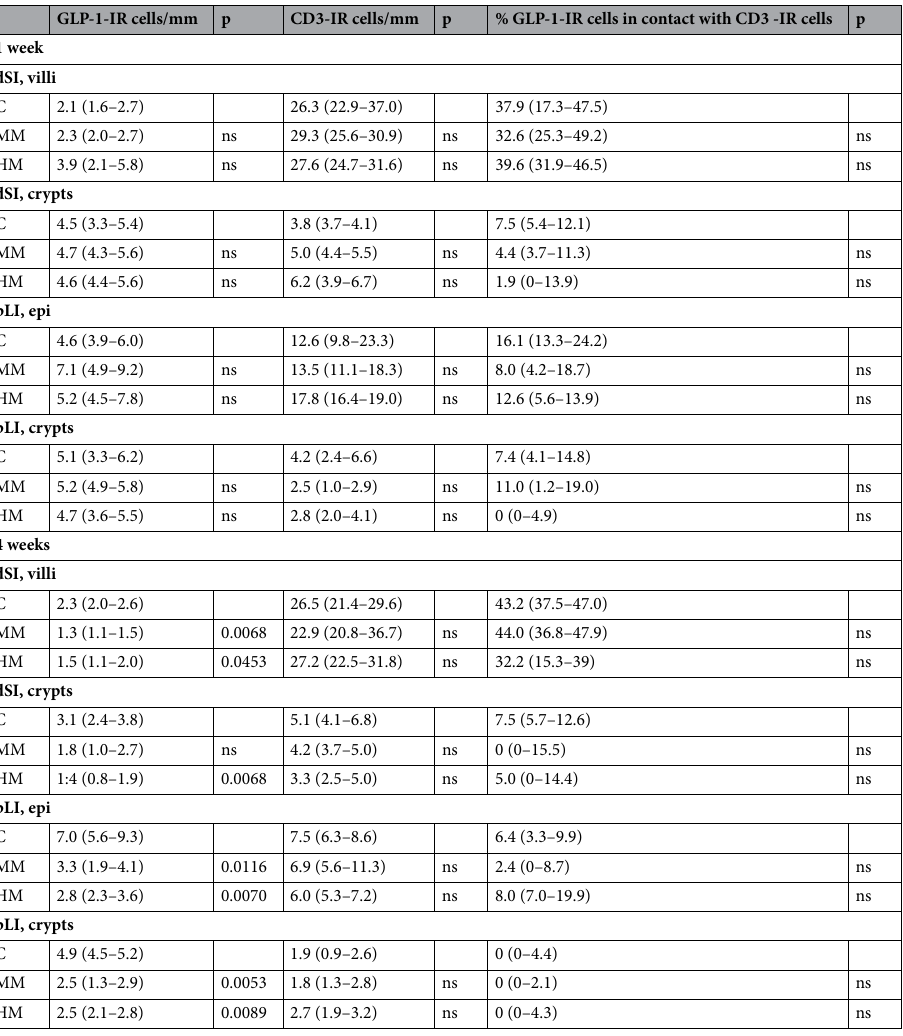
Table 3. Numbers of glucagon-like peptide-1 (GLP-1)- and CD3-immunoreactive (IR) cells per mm intestinal epithelium and relative frequency of GLP-1-IR cells in close contact with CD3-IR cells in villi and crypts from distal small intestine (dSI) and surface epithelium (epi) and crypts from proximal large intestine (pLI) as estimated on immunostained sections from rats fed control (C), medium Maillard (MM) or high Maillard (HM) containing diets for 1 or 4 weeks.Values from rats fed 1 week (n = 4) or 4 weeks (n = 10–11) expressed as median (interquartile range). Kruskal–Wallis followed by Dunn´s multiple comparison test), p p-value as compared to C, ns no significant differences compared to C.